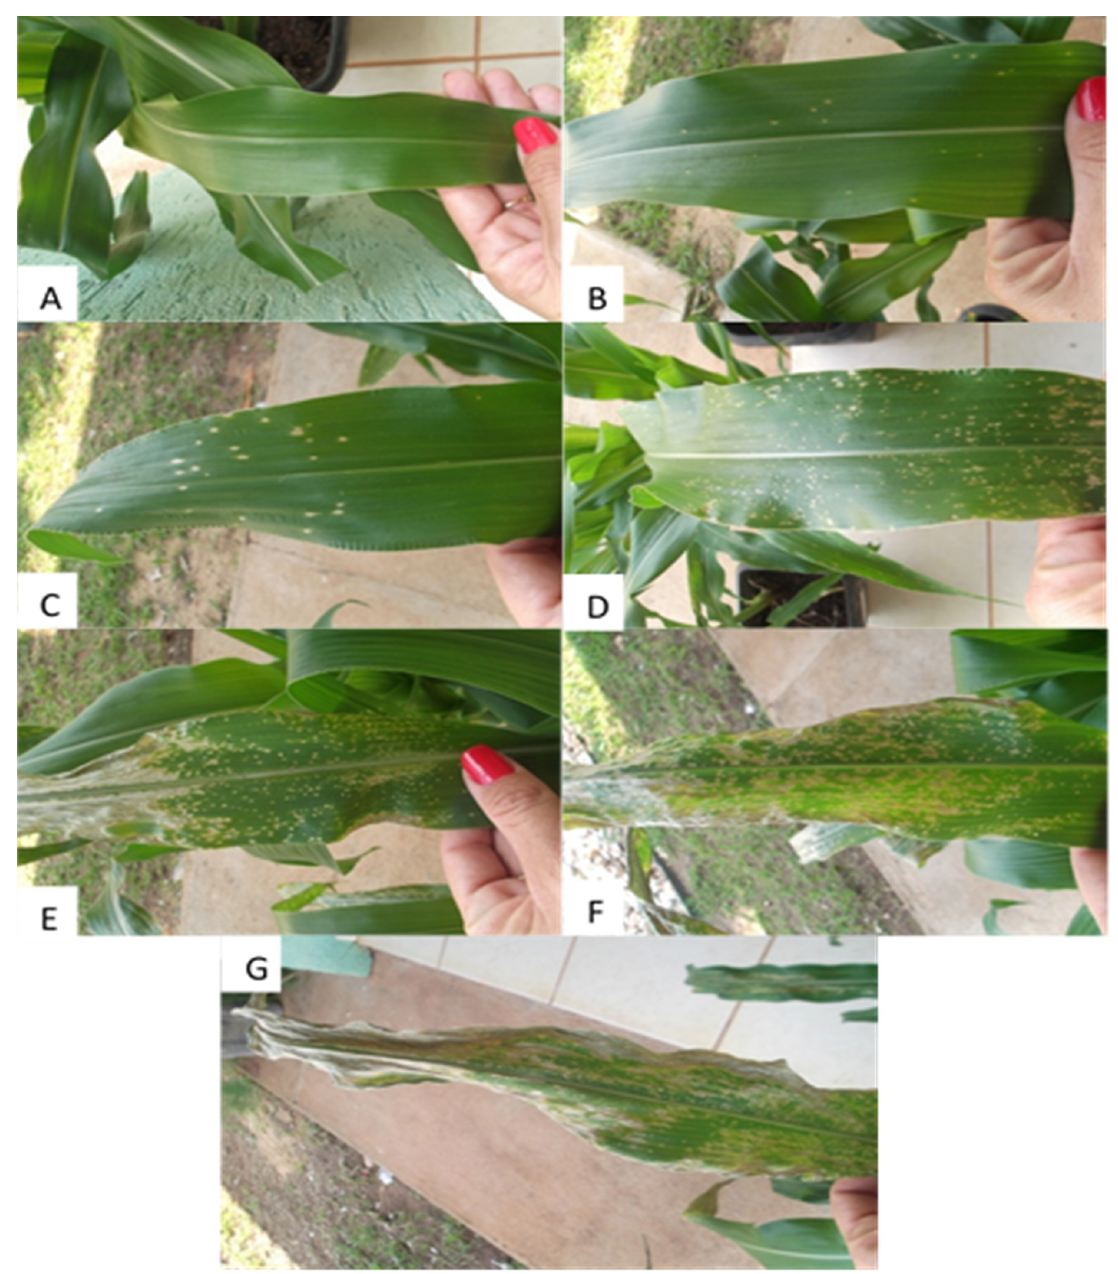
Figure 1. Severity of the Curvularia Leaf Spot disease in maize plants, submitted to the inoculation with different conidia concentrations of Curvularia lunata . ( A —Control; B —10 1 conidia mL − 1 ; C —10 2 conidia mL − 1 ; D —10 3 conidia mL − 1 ; E —10 4 conidia mL − 1 ; F —10 5 conidia mL − 1 ; G —10 6 conidia mL − 1 ).